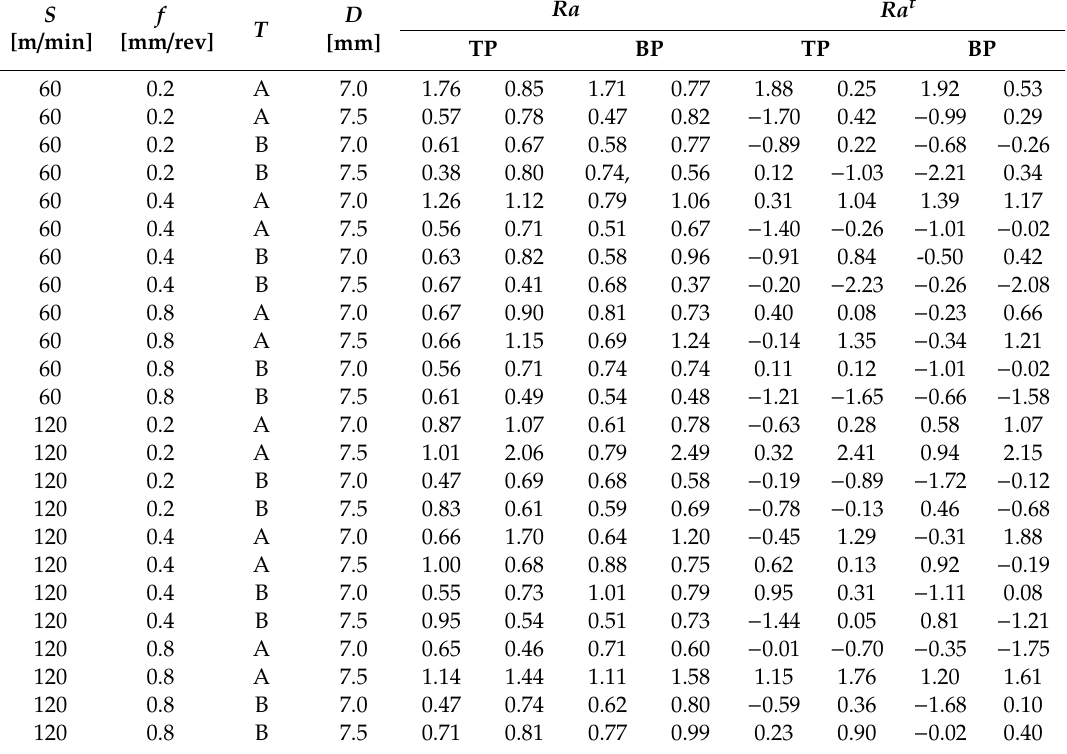
Table 4. Replicas of original and transformed data of Ra in µ m, at di ff erent measurement depths.